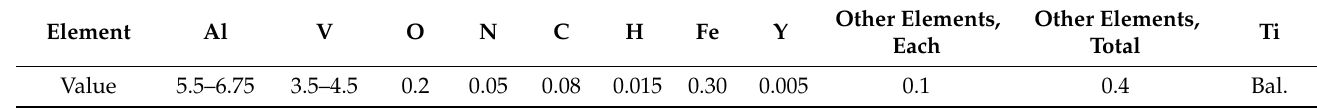
Figure 2. View of 3D models, CAD, ( a ) isometric view, ( b ) view of the saved .stl file, ( c ) view of the proposed saving of .stl files, too accurate, ( d ) magnified view of geometric features highlighted in red. Table 1. The chemical composition of the powder (wt, %).